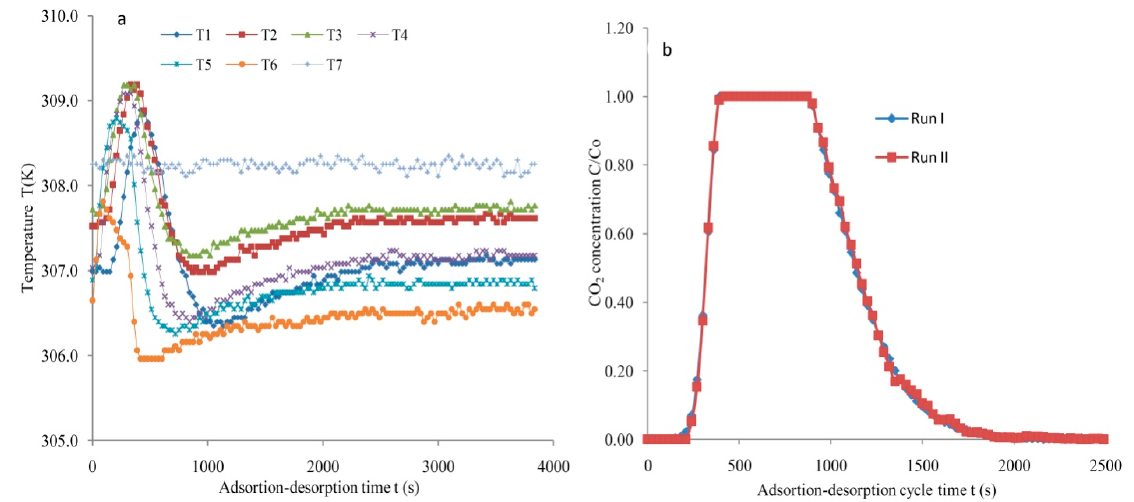
Figure 15. ( a ) Temperature contours for SG at F = 4 lpm and C o = 5%, ( b ) repeatability assessment utilizing SG at F = 4 lpm, C o = 5% and T = 308 K, ( c ) temperature contours for AC at F=4 lpm and C o = 5% and ( d ) repeatability at F = 4 lpm, C o = 5% and T = 308